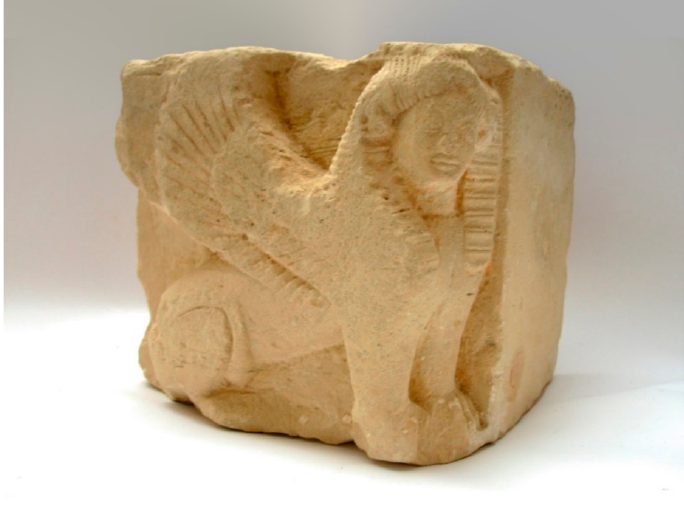
Figure 2. Winged sphinx (MGW inv. no. 2509); limestone relief block; ca. 6th–5th century BCE . All photographs courtesy of the Whitaker Foundation, Motya.